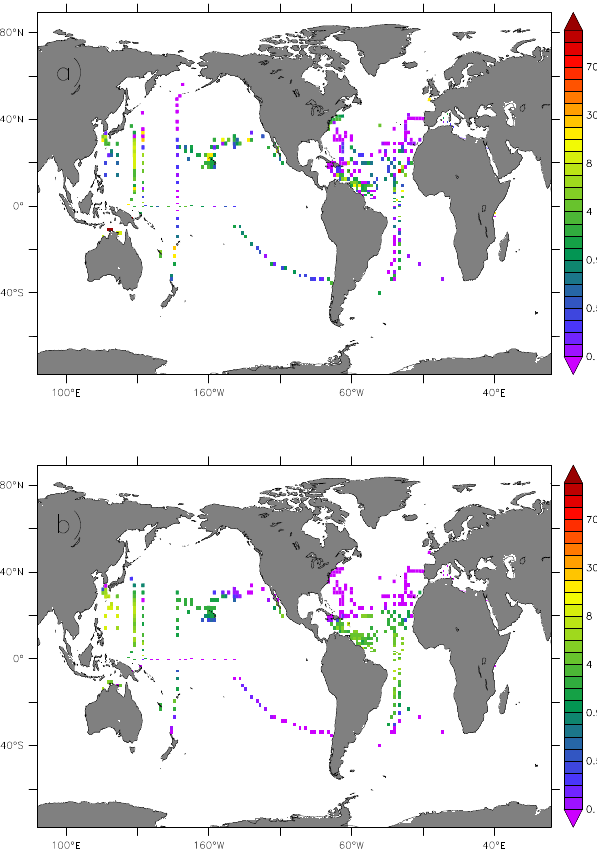
Figure 6. Annual-mean depth averaged N 2 fixation rates in µmolNm − 2 d − 1 . (a) Database from the MARine Ecosystem Model Intercomparison Projec (MAREMIP) project (Luo et al., 2013); (b) model